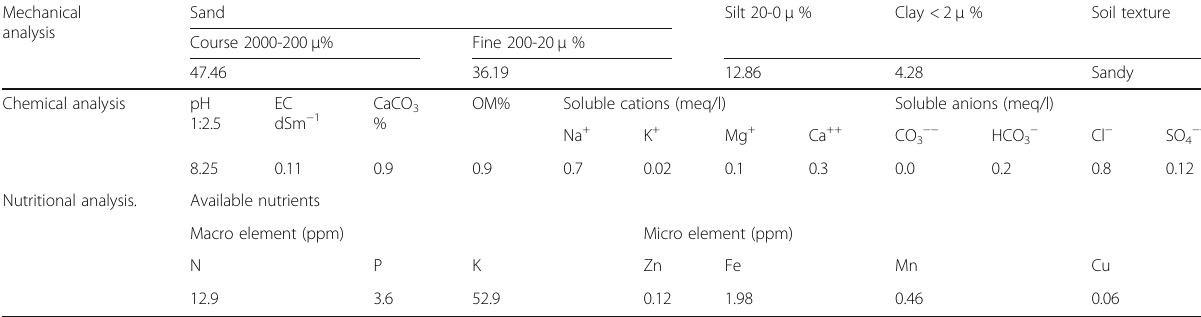
Table 1 Mechanical, chemical, and nutritional analysis of the experimental soil Mechanical analysis